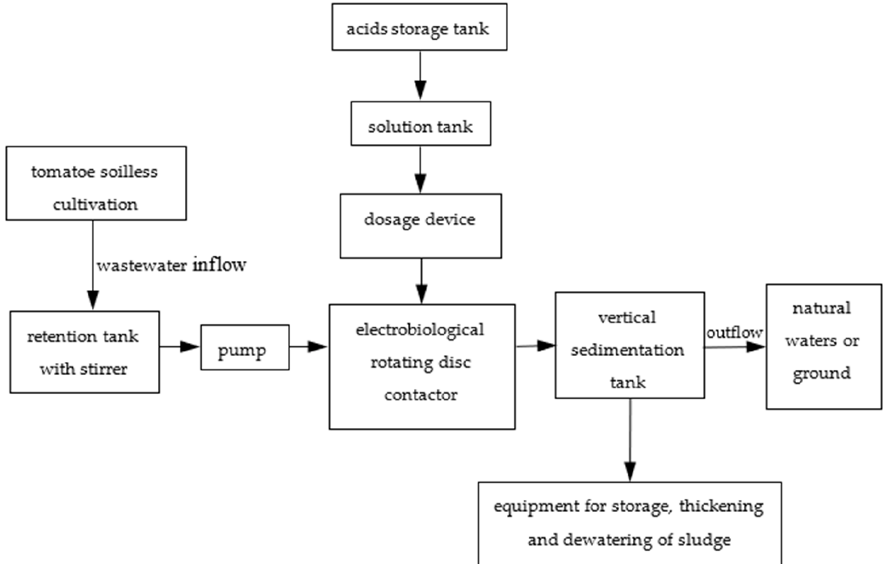
Figure 7. Scheme of a technological system with an electrobiological rotating disc contactor with external carbon source for treating wastewater discharged into natural waters or the ground.